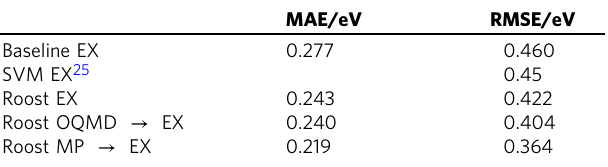
Table 2 Transfer Learning Benchmarking on EX. The table shows the ensemble mean absolute error (MAE), and root mean squared error (RMSE) for the three transfer learning scenarios and baselines on 20% of the data that was randomly sampled and withheld as a test